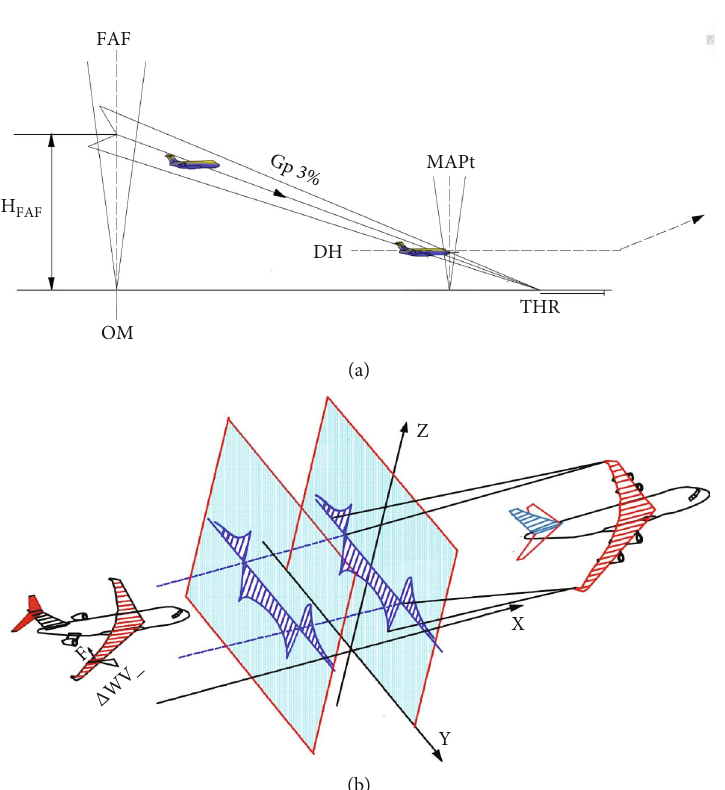
Figure 16: The ARJ21 encounter wake coordinate system in the fi nal approach segment. (a) Precision approach procedure and (b) the three-dimensional coordinate system of the wake